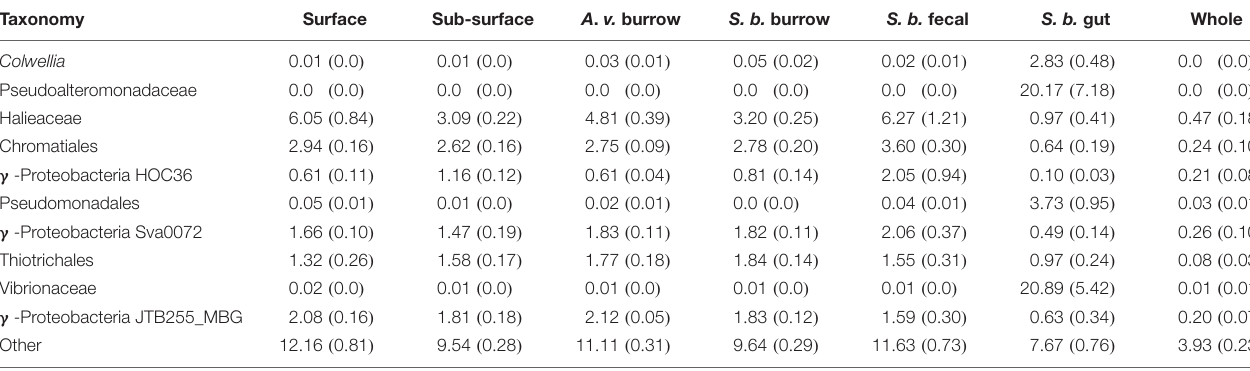
TABLE 3 | Major contributors to Gammaproteobacteria in surface, sub-surface, Alitta virens ( A . v .) burrows, Saccoglossus bromophenolosus ( S . b .) burrows, S. bromophenolosus fecal casts, S. bromophenolosus gut contents, and sediment-free whole S. bromophenolosus (Whole) microbial communities.